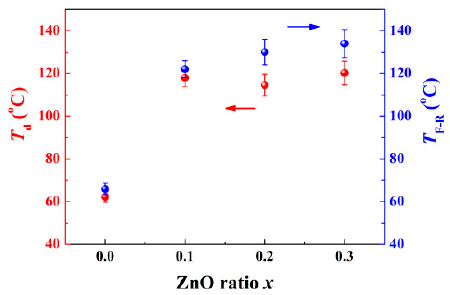
Figure 5. T d and T F-R as a function of ZnO ratio x .